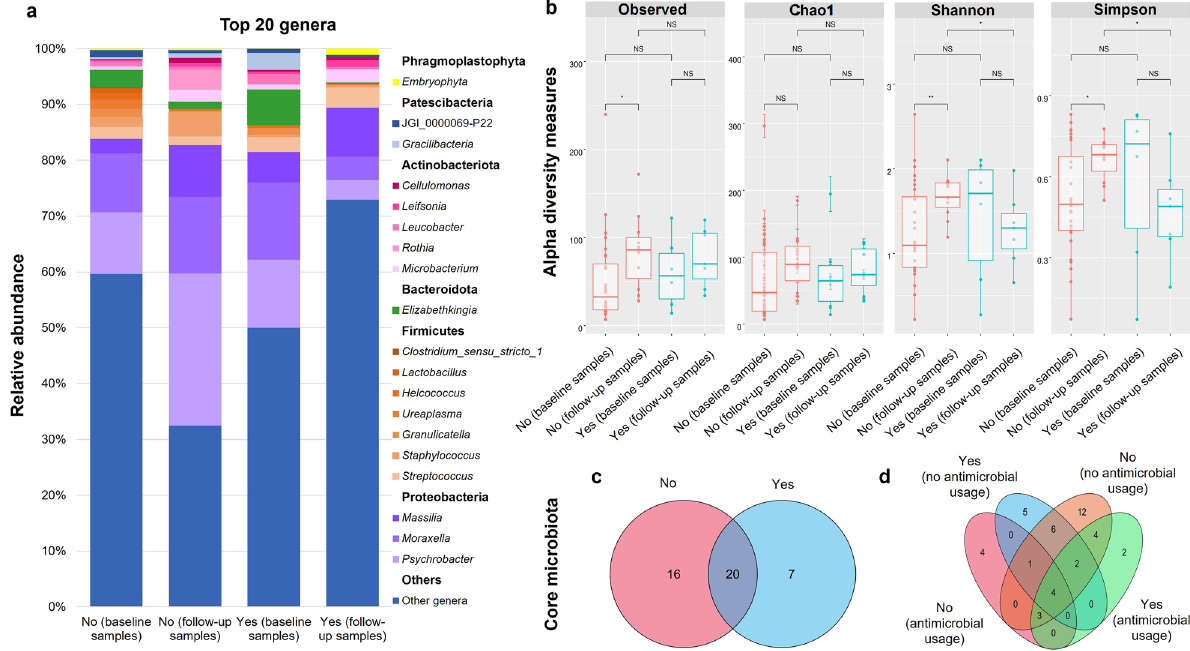
Figure 1. Microbiota analysis of nasal samples from dogs with (yes) and without (no) dermatological conditions displaying (a) relative abundance (%) of the top 20 genera for the baseline and follow-up samples; (b) alpha diversity plots of observed richness, Chao1, Shannon Index, and Simpson’s Index for the baseline and follow-up samples using Wilcoxon rank-sum test significance [p > 0.05 = NS (not significant), *p < 0.05, **p < 0.01]; (c) core microbiota at genus level from nasal samples of dogs with and without dermatological conditions; (d) core microbiota at genus level of nasal samples from dogs with dermatological conditions that were prescribed antimicrobials (yes—antimicrobial usage) and not prescribed antimicrobials (yes—no antimicrobial usage) and from dogs without those conditions prescribed antimicrobials (no—antimicrobial usage) and not prescribed antimicrobials (no—no antimicrobial